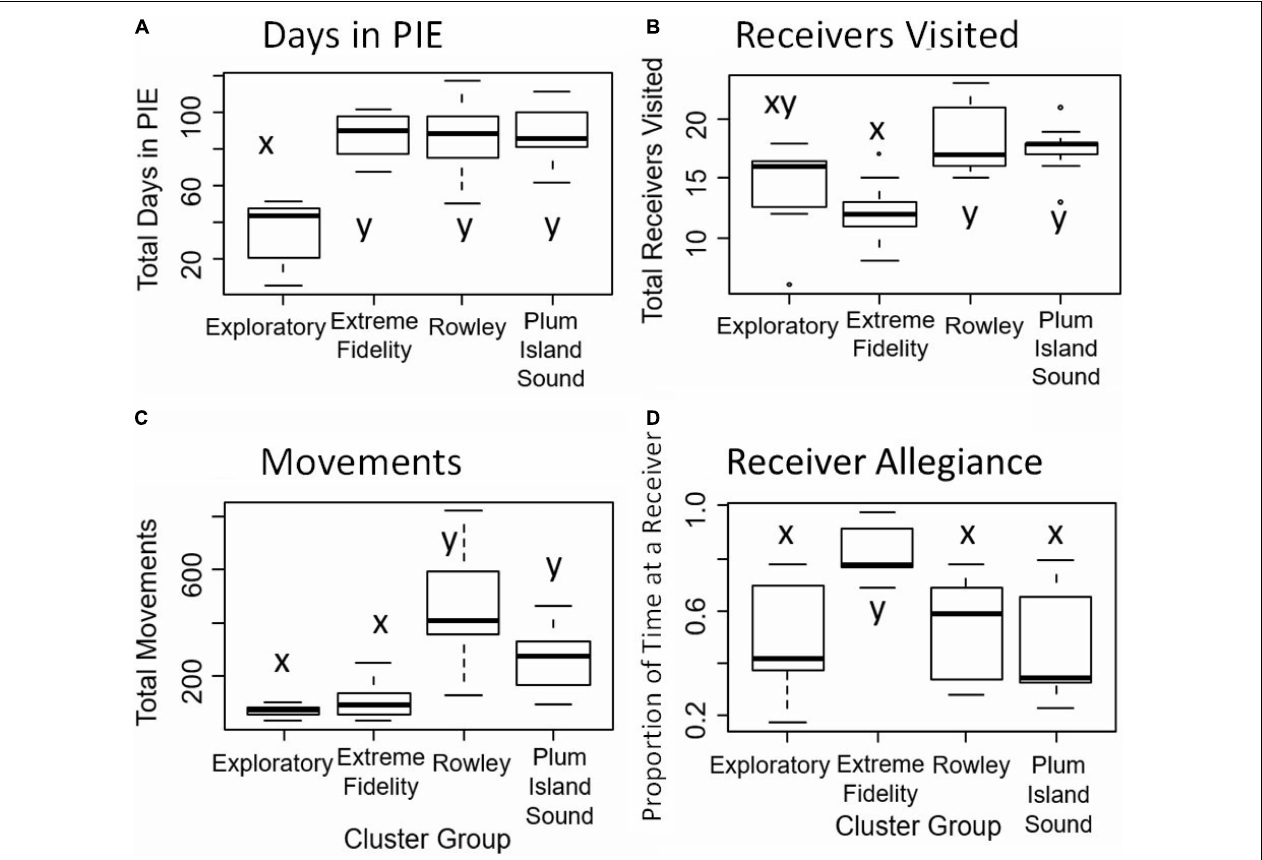
FIGURE 4 | For the four clusters (Exploratory, Extreme Fidelity, Rowley, and Plum Island Sound; X axis), shown are the box plots of metrics used in the cluster analysis ( Y axis). Metrics include: (A) total days in PIE , (B) total receivers visited , (C) total number of movements , (D) receiver allegiance . Receiver allegiance is the proportion of time a fish spent at the single most visited receiver. Letters indicate statistical